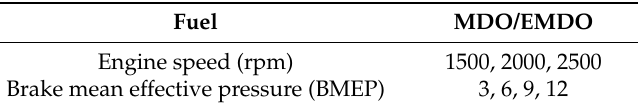
Table 5. Engine test conditions.